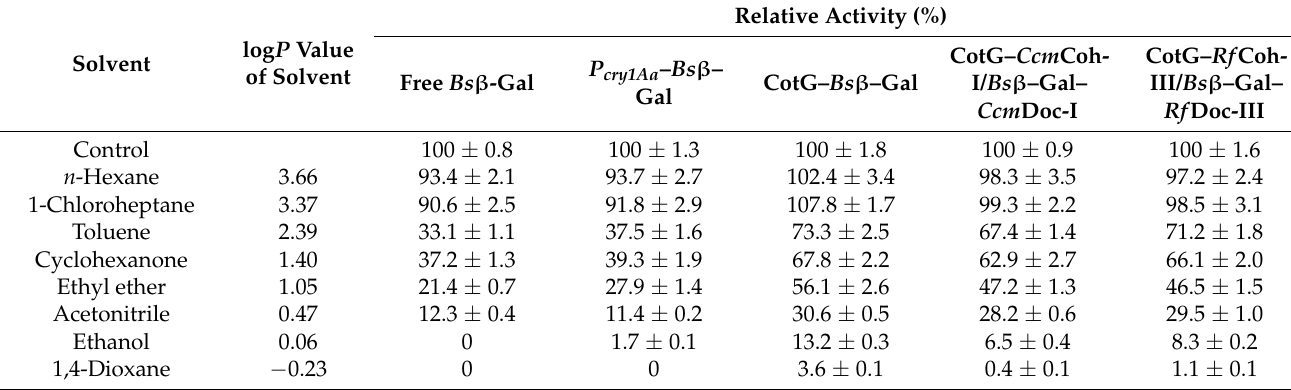
Table 2. Stabilities of spore displayed and free Bs β –Gals in various organic solvents.